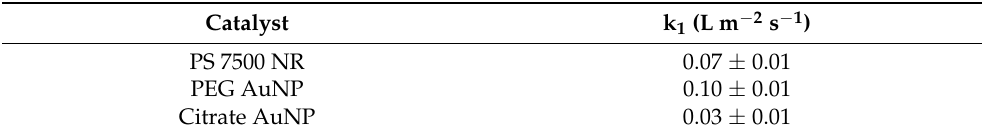
Table 1. 4-Nitrophenol reduction rate constants of polymer nanoreactors and gold colloids using